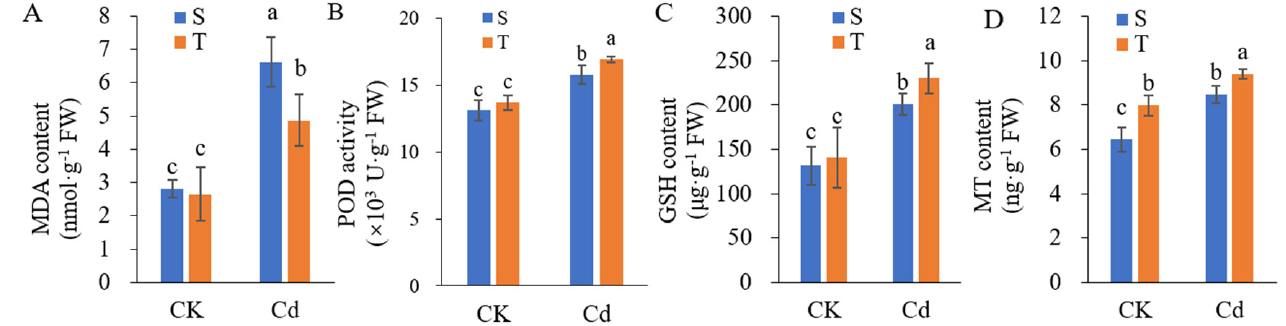
Figure 3. The malondialdehyde (MDA) content ( A ), peroxidase (POD) activity ( B ), glutathione (GSH) content ( C ), and metallothionein (MT) content ( D ) in the Cd-sensitive variety (S) and Cd-tolerant variety (T) under control (CK) and Cd stress conditions. The values shown are means ± SE ( n = 3). Different lowercase letters above each bar represent significant differences among treatments and varieties ( p <